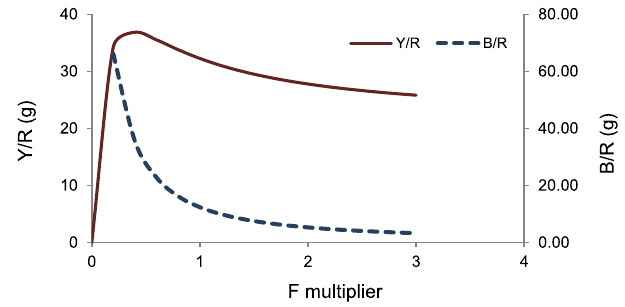
Fig. 6. Yield per recruit and biomass per recruit for S. undosquamis at different multiples of fi shing mortality (F) using Thompson and Bell Prediction